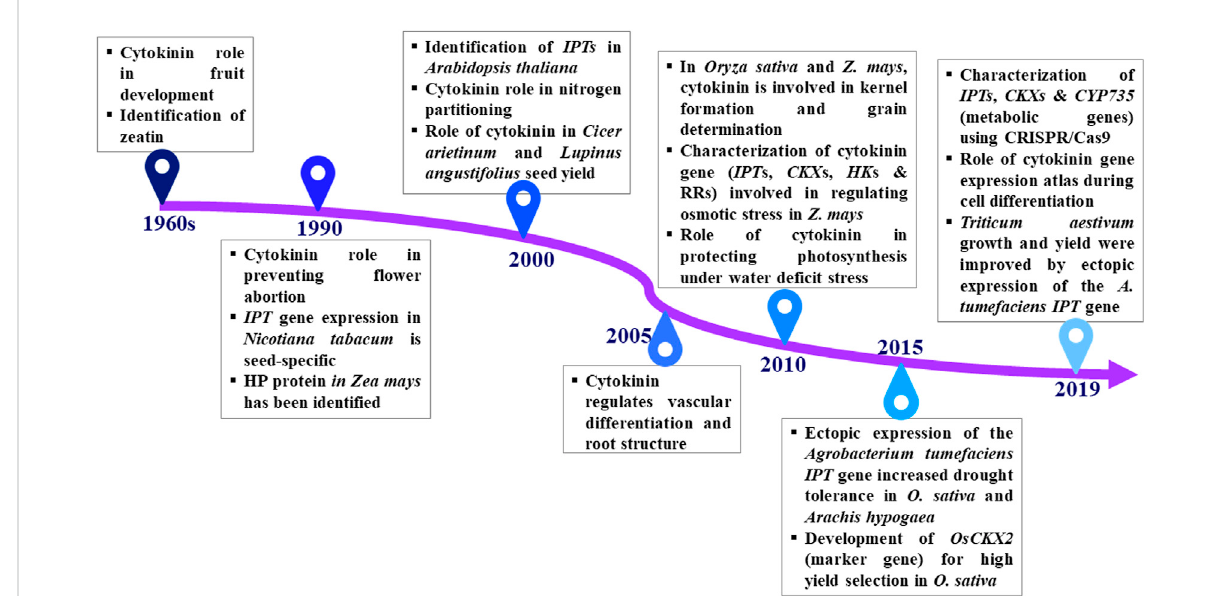
FIGURE 2 Cytokinin timeline: from discovery to crop plant application. A chronology of signi fi cant advancements in cytokinin research. Abbreviation: CKXs, CK oxidases/dehydrogenases; RRs, cytokinin response regulators; IPTs, isopentenyl transferases; HK, histidine